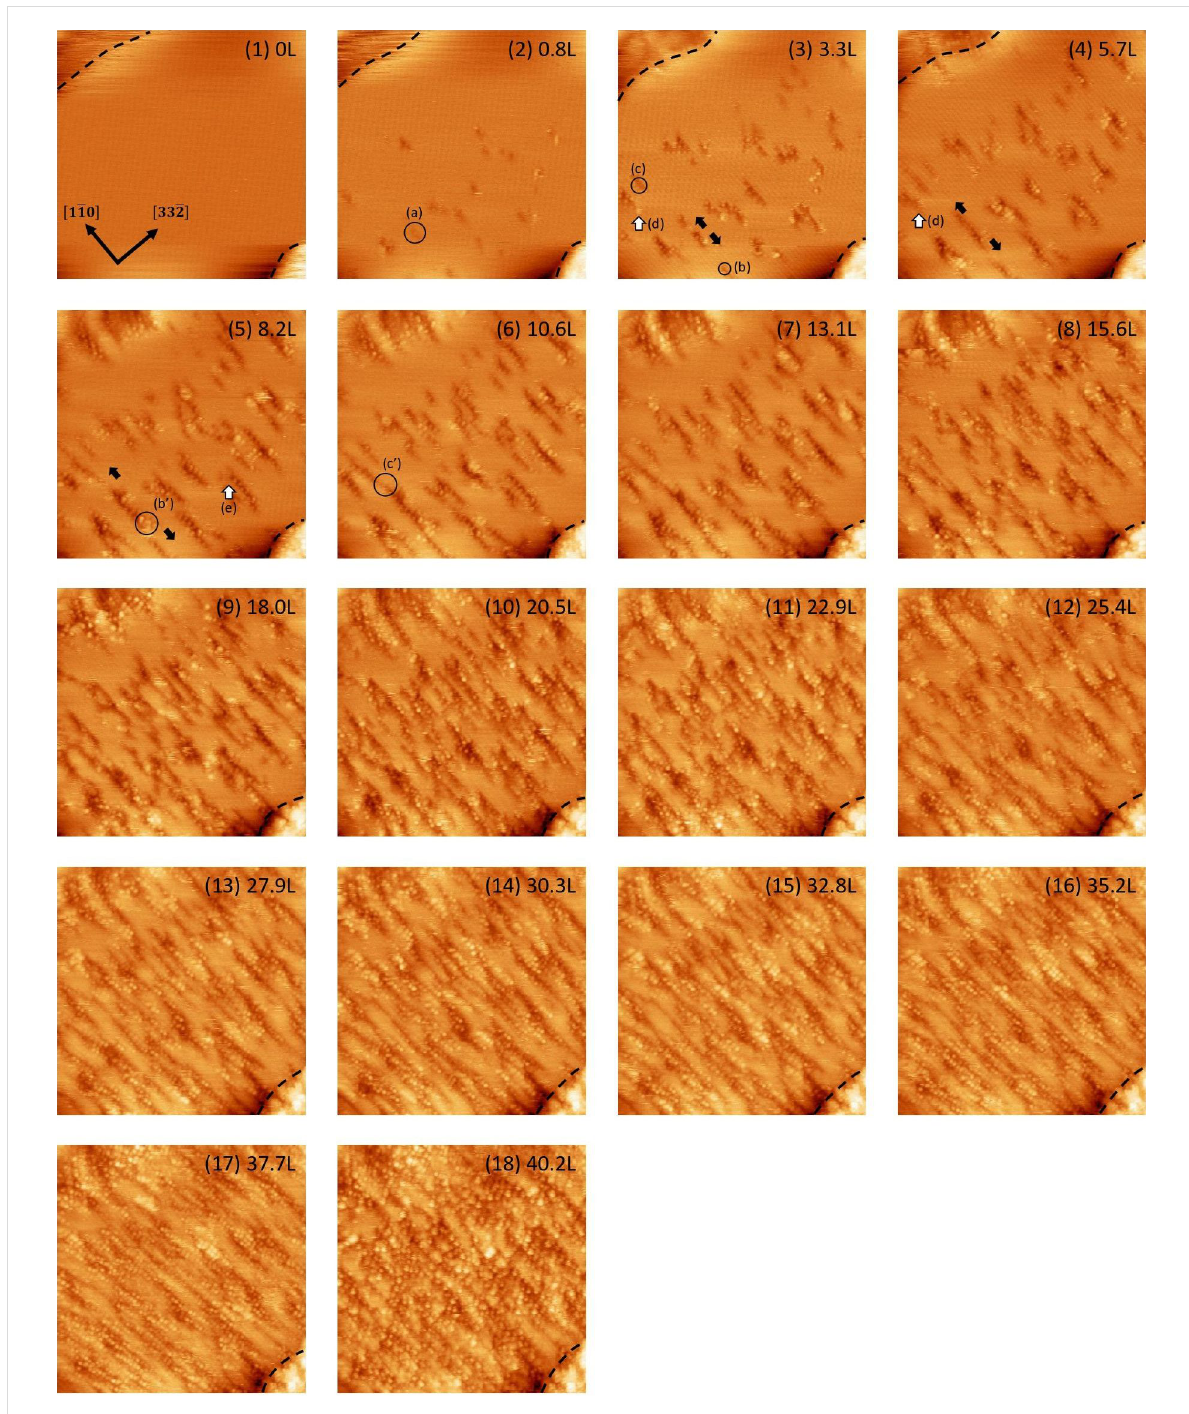
Figure 2: A series of filled-state STM images of Si(113)-(3 × 2) upon oxidation at an oxygen pressure of 1.3 × 10 − 5 Pa and a sample temperature of 820 K. A Langmuir unit is defined such that 1.0 L = 1.33 × 10 − 4 Pa·s. Image size: 40 × 40 nm 2 , V s = − 1.6 V, I t = 0.07 nA.